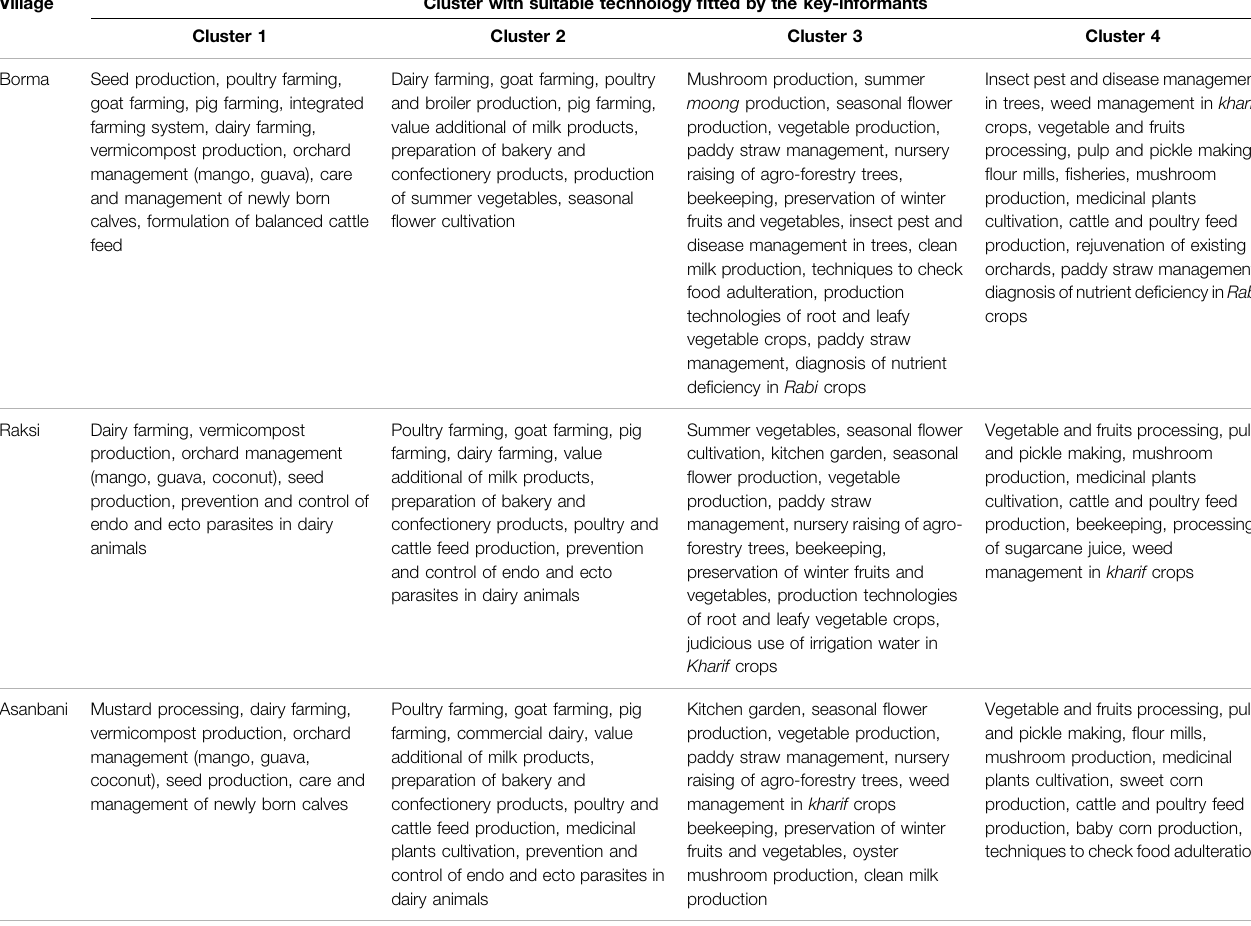
TABLE 6 | Fitting of agricultural technologies to the identi fi ed clusters by the key-informants.